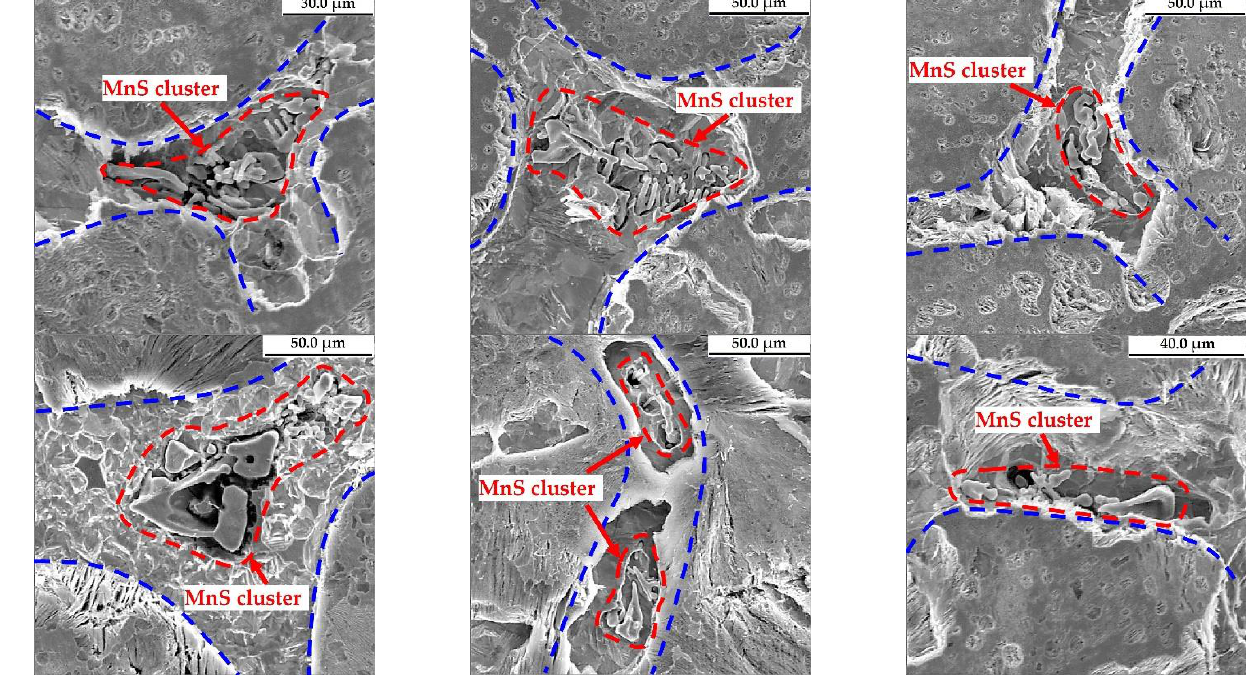
Figure 6. Typical morphologies of MnS inclusions aggregation in the slab of medium carbon structural steel 45#.